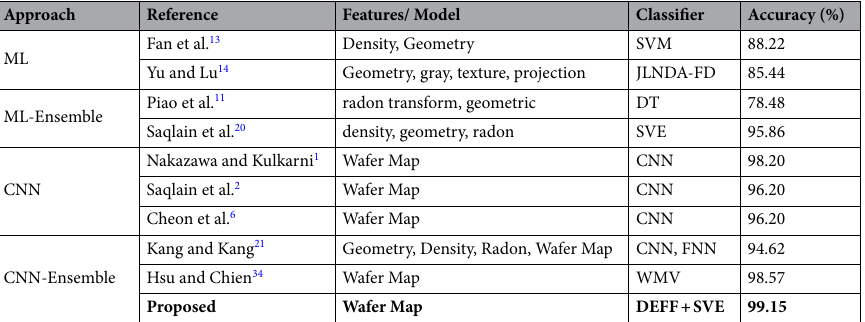
Table 5. Classification performance (accuracy) of proposed and existing methods. The best performance is shown in bold font. ML machine learning, CNN convolutional neural network, SVM support vector machine, JLNDA joint local and nonlocal linear discriminant analysis, FD fisher discriminative, DT decision tree, SVE soft voting ensemble, FNN feed-forward neural network, WMV weighted majority voting, DEFF deep ensemble feature